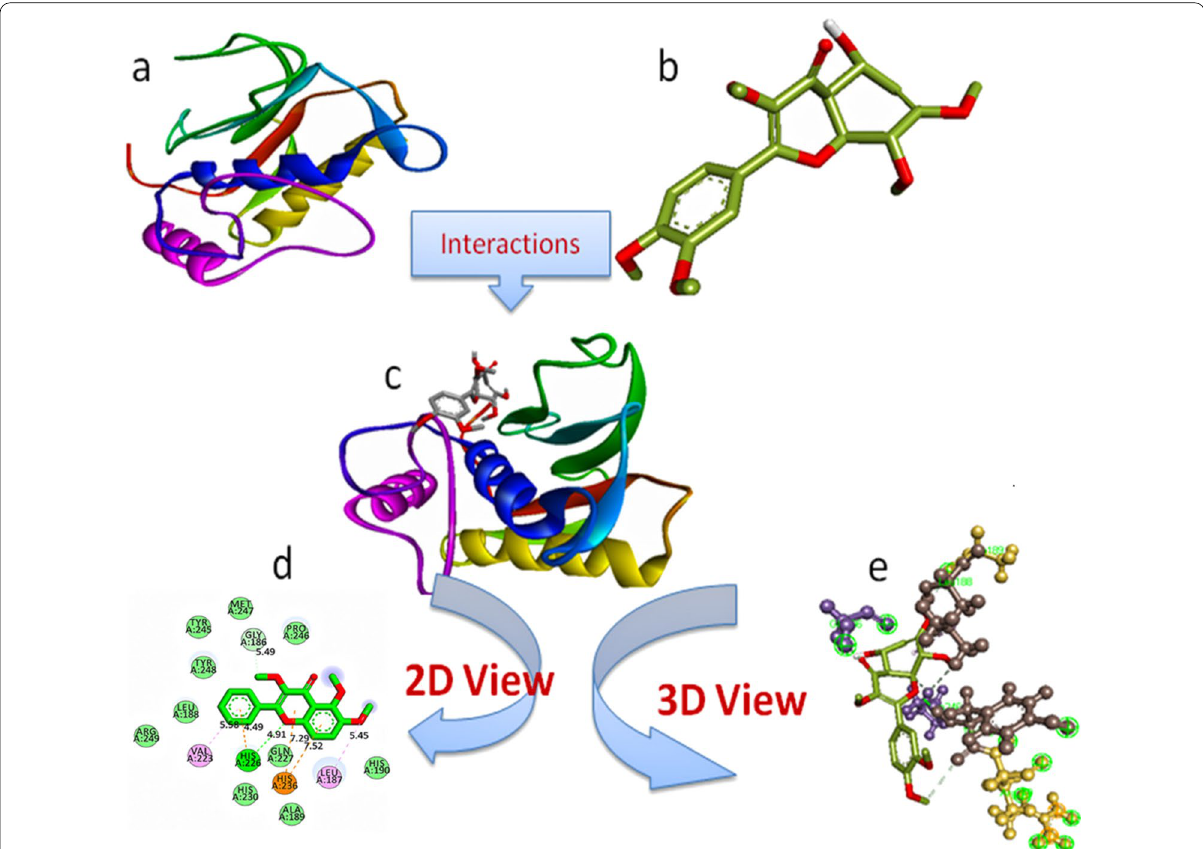
Fig. 2 Autodock of 6ESM (MMP9) with TMF a The three-dimensional structural representation of MMP9. b The three-dimensional structure of TMF. c The molecular representations of Docked complexes. d 2D Interactions of ligand and protein. e Interaction of ligand with MMP9 at Tyrosine